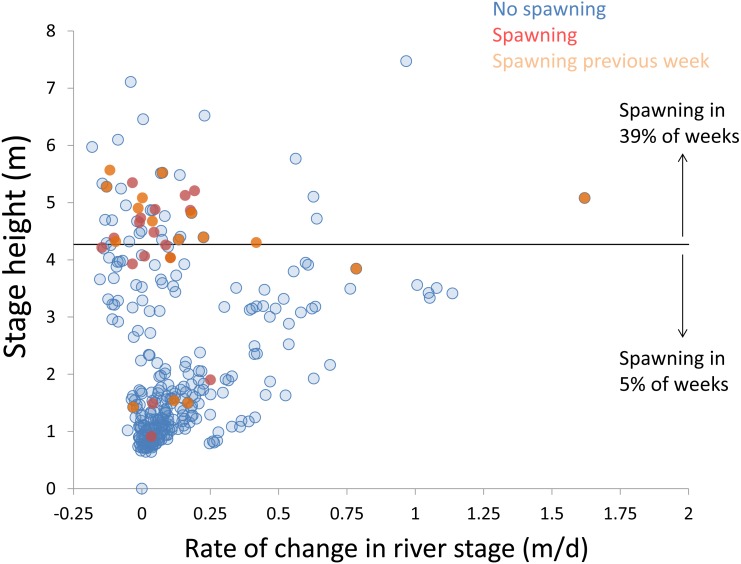
Hydrologic variables influencing bigheaded carp spawning across years.Scatterplot depicting stage height (m) and rate of change in the river stage height (m/d) in weeks without detected spawning (blue points), with detected spawning (red points), and with spawning detected the previous week (orange points). The horizontal black bar depicts the flood stage (4.27 m).